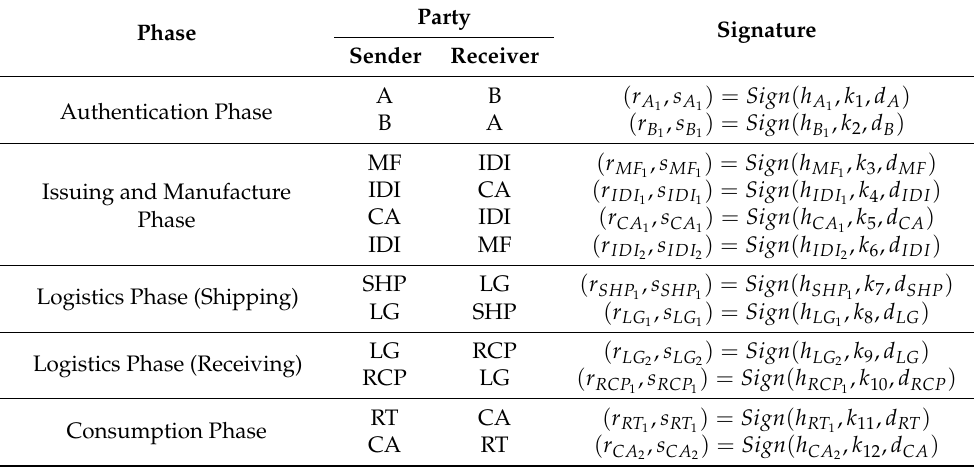
Table 3. Non-repudiation’s verification of the proposed